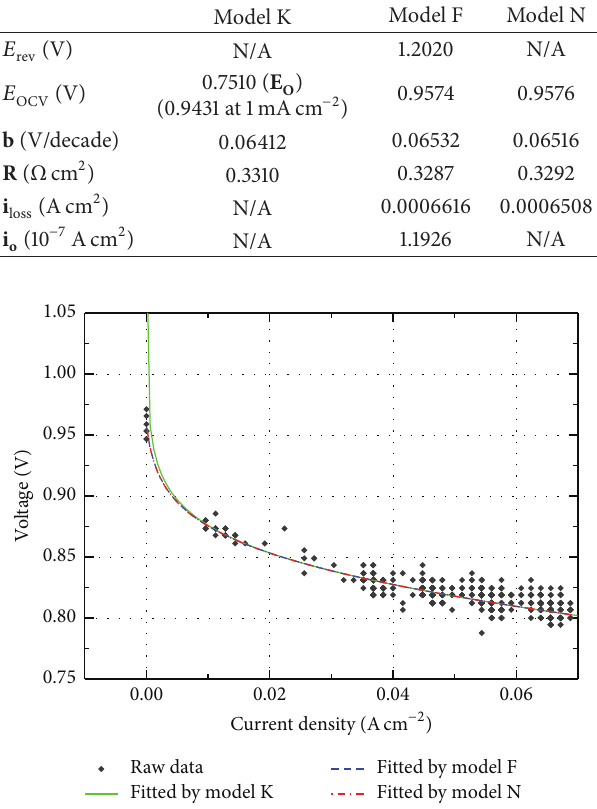
Figure 8: Comparison of measured and fitted polarization curves (small current densities) (road